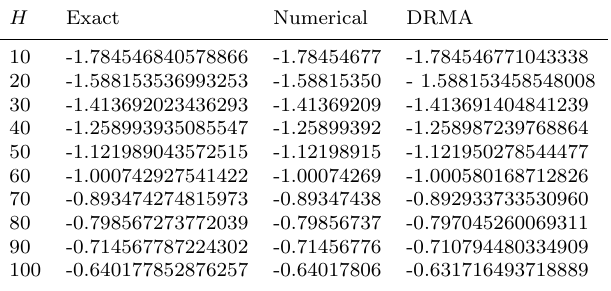
Comparison between the exact, numerical results [1] and DRMA solutions for γ = f (cid:48)(cid:48) (0) for different values of Hartmann numbers when α = − 5 0 and Re = 10 . H